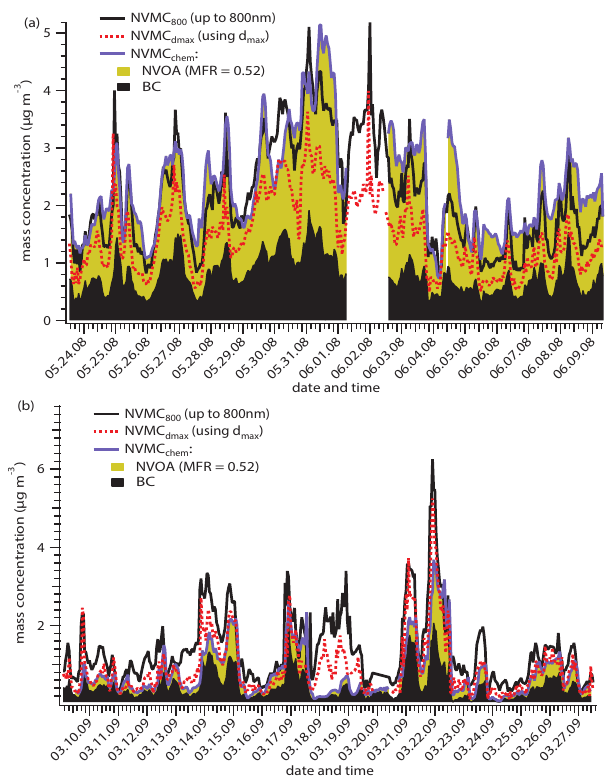
Figure 4. Time series of the estimated non-volatile OA (NVOA) and BC for (a) May–June 2008 and (b) February–March 2009. Time series of the resulting estimated and measured non-volatile mass concentration (NVMC) are included as blue and black solid lines, respectively. The V-TDMPS results were converted in mass concen- tration assuming a constant density of 1.6gcm − 3 . The red dotted lines correspond to NVMC measured with a time-dependent upper size cutting d max (see discussion in